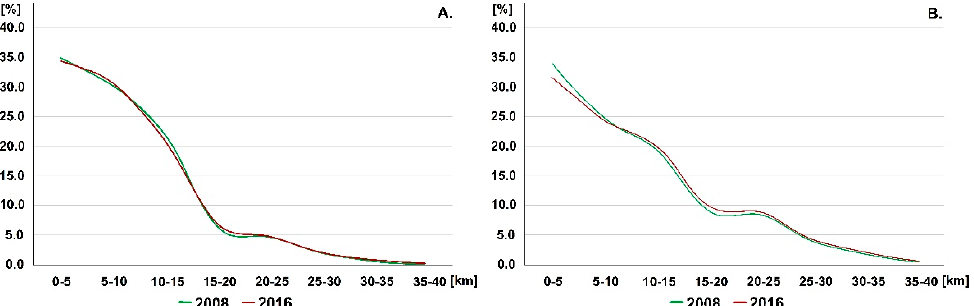
Figure 13. Change in the distribution of high ( A ) and low ( B ) technology industrial entities in the Wrocław agglomeration depending on the distance from the center of its core in 2008–2016 (sourced by authors).